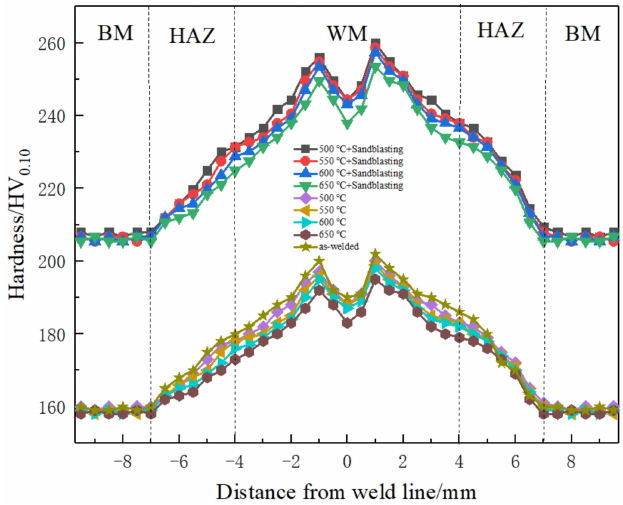
Figure 7. Microhardness of each area after